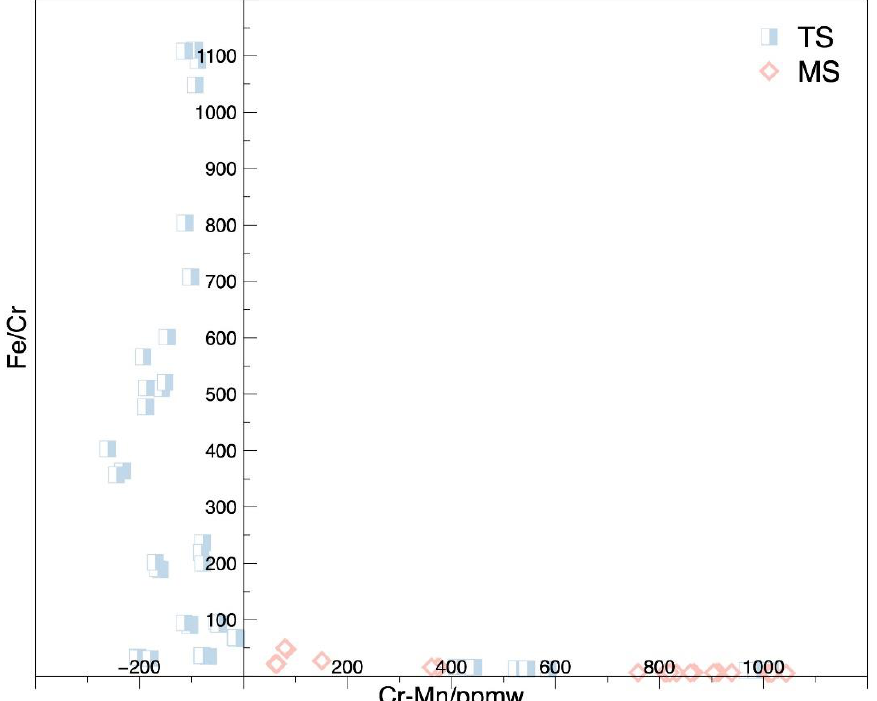
Figure 10. The Fe/V+Mn+Cr ternary diagram shows that the data clusters for the two spinel occurrences can be distinguished to a great extent.